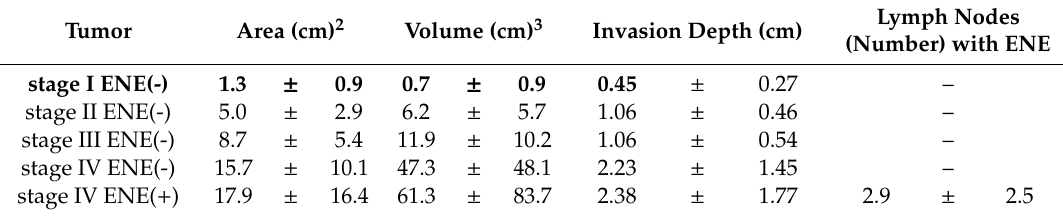
Table 2. Area, volume, and lymph nodes with ENE of the